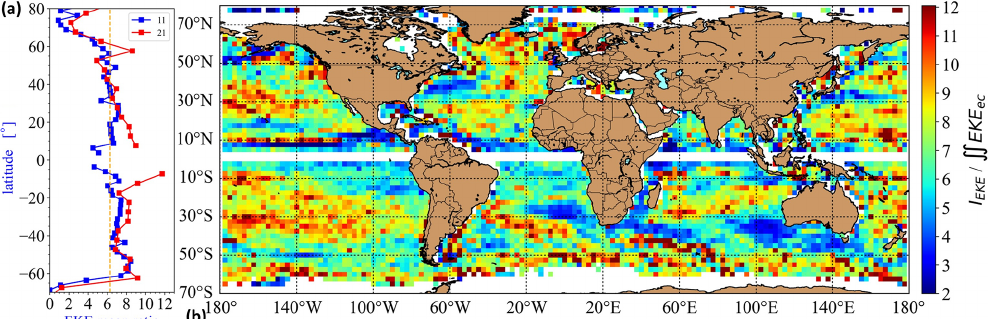
Figure 6. Temporal mean eddy kinetic energy ratio I EKE / (cid:82)(cid:82) EKE ec . The latter estimated from the squared amplitude parameters η 2 ec of the eddy census by Eq. (3). (a) Zonal mean values for the tilings of 11 × 11 (blue) and 21 × 21 (red) grid cells. The vertical dashed line (orange) is not fitted and is only for orientation. (b) Geographic distribution for the tiling of 11 × 11 grid cells. The white band indicates the equatorial region where estimates diverge because the Coriolis parameter ∼ sin (ϕ) in the denominator of Eq. (3) tends to zero. The color scale is